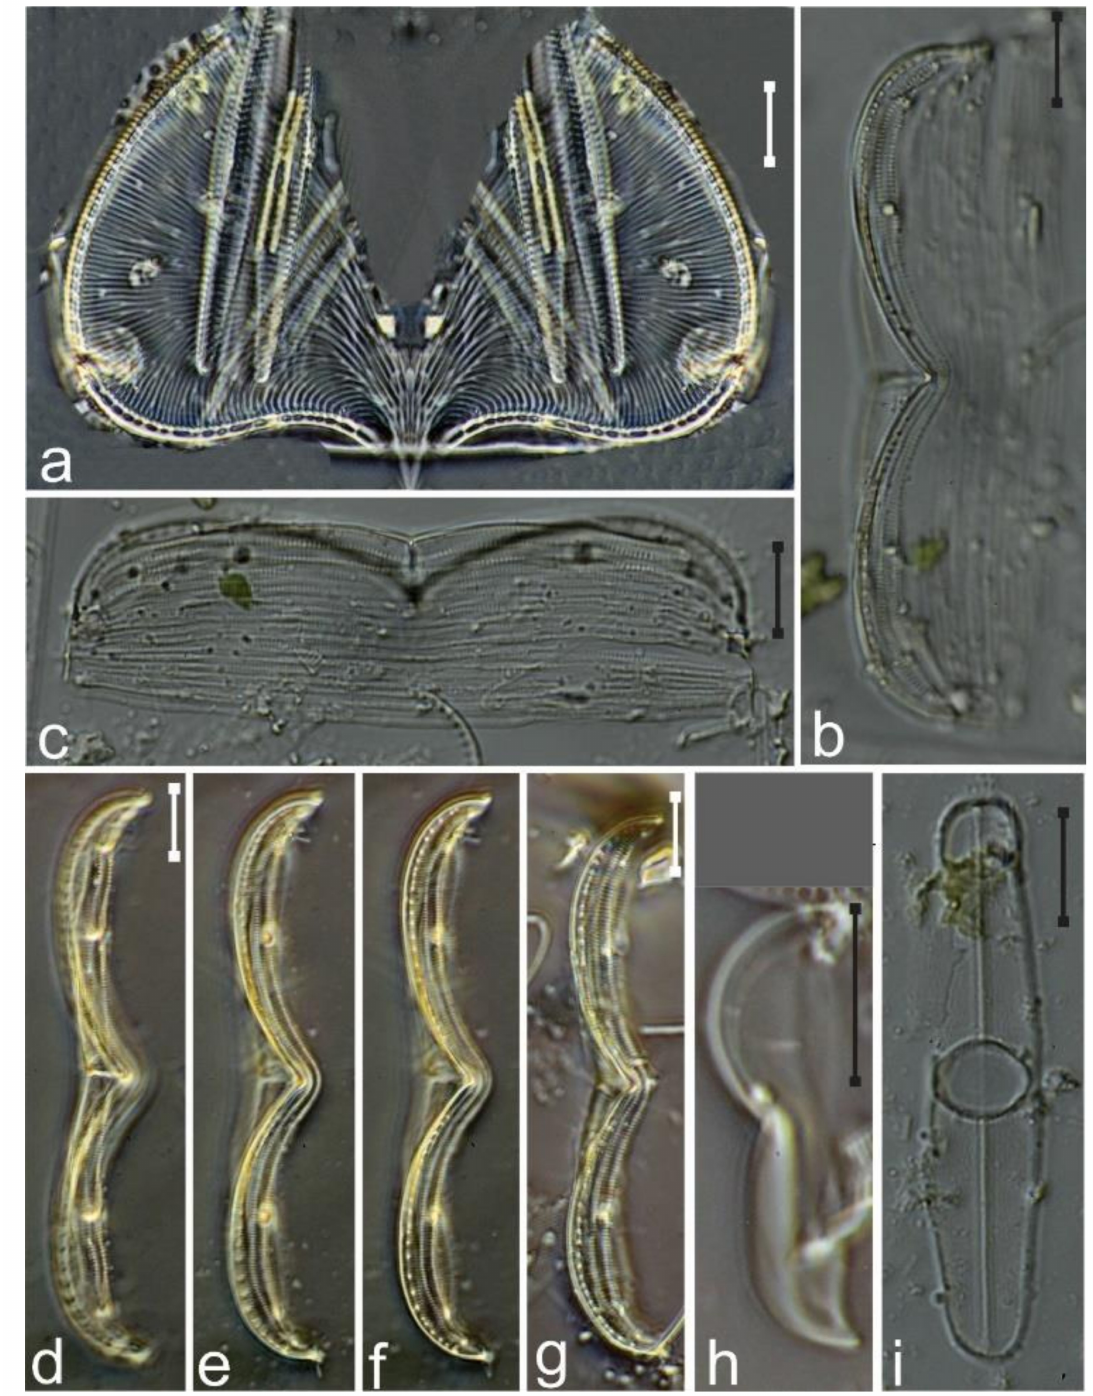
Figure 37. ( a ) Auricula flabelliformis ; ( b – g ) A. pulchra ; ( h ) Amphiprora pseudoduplex ; ( i ) Cyclophora tenuis . Scale bar = 10 µ